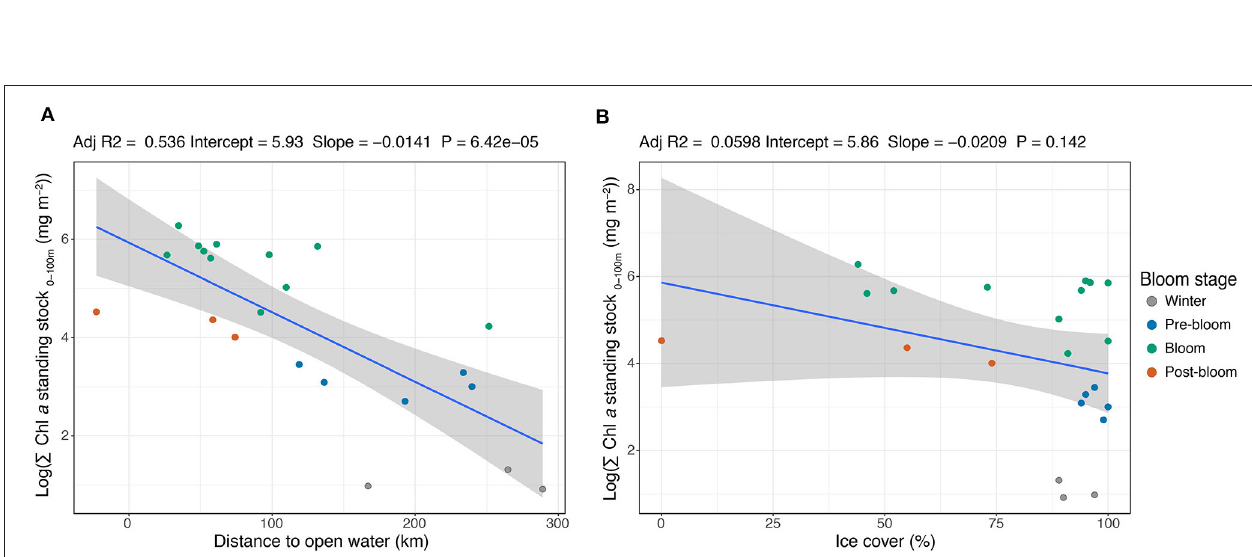
FIGURE 5 | Linear regression between the stations’ ( n = 22) depth-integrated Chl a standing stock in the upper 100m of the water column (on a logarithmic scale) and (A) the distances to open water (classified as < 15% sea ice cover) and (B) sea ice cover. The regression fit ( r 2 ), intercept, slope, and P -value are shown above the respective figures. Note that the negative value for distance to open water refers to a station in open water and its distance from the ice edge, while the other positive values were all stations with sea ice cover > 40%.